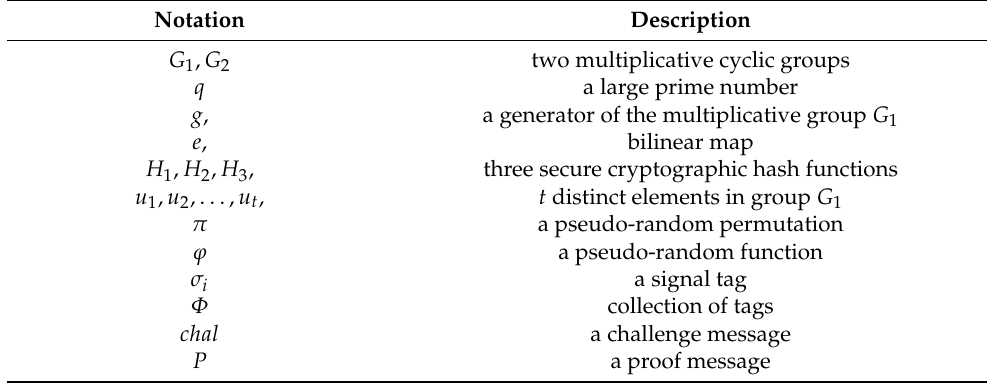
Table 2. Mathematical notation.